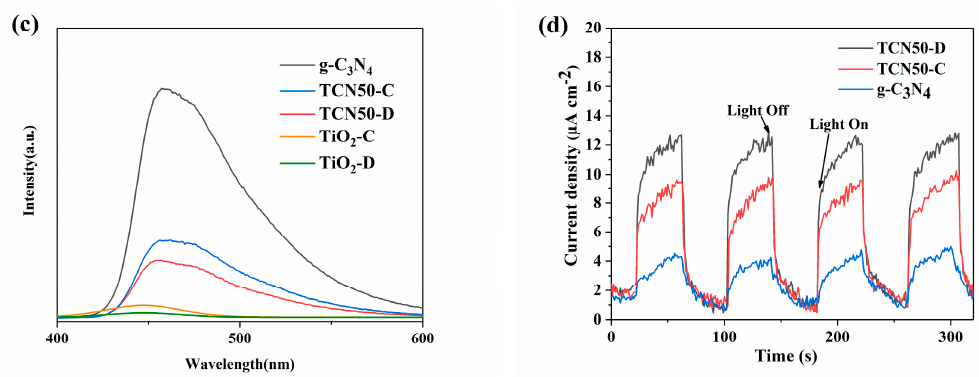
Figure 4. ( a ) UV–vis DRS of TiO 2 , g-C 3 N 4 , TCN50-C and TCN50-D samples. ( b ) The relationship between (ahv) 2 and photo energy. ( c ) Photoluminescence spectra of g-C 3 N 4 , TiO 2 and TCN50 samples. ( d ) Photocurrent density vs. time for g-C 3 N 4 /FTO, TCN50-C/FTO and TCN50-D/FTO.